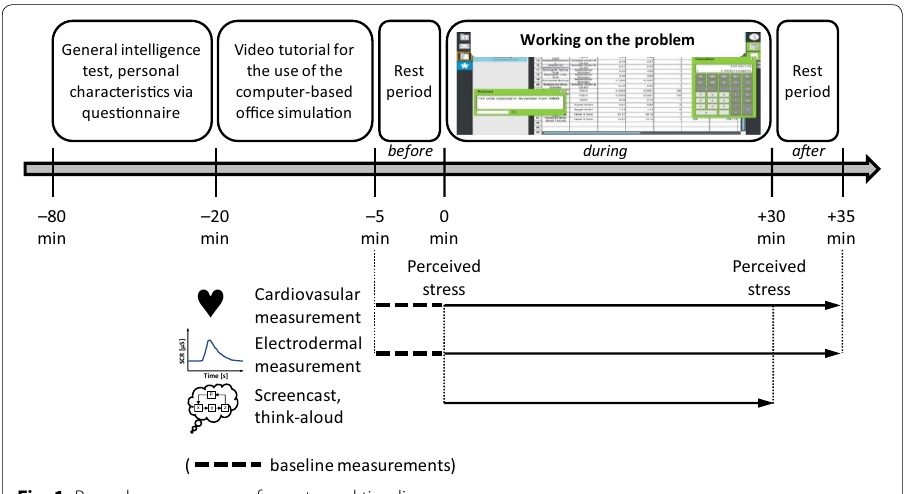
Fig. 1 Procedure, sequence of events, and